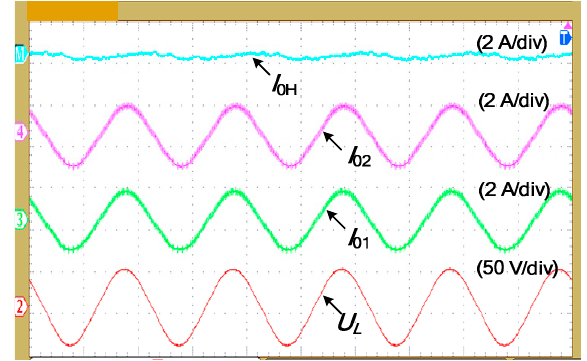
Figure 10. Steady state experimental waveforms using the proposed method.